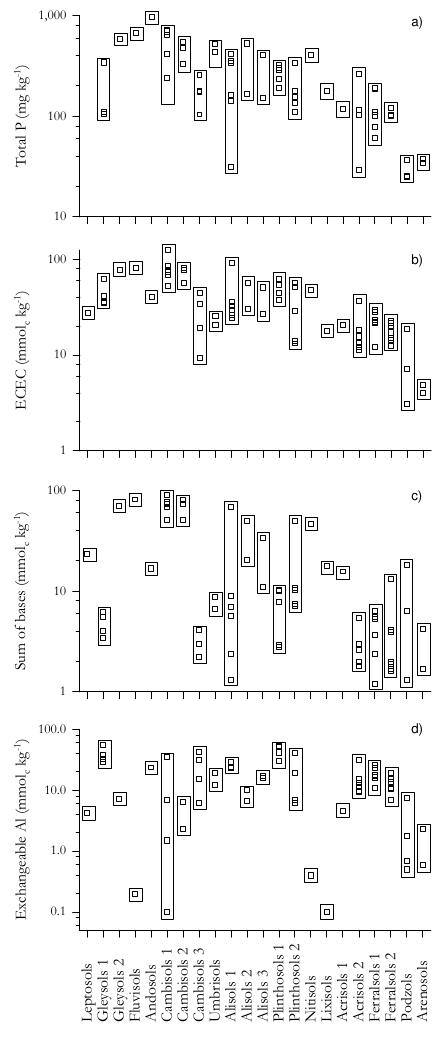
Fig. 3. (a) and (b) : Ranges of total phosphorus (top) and effective cation exchange capacity ( I E below) across the soil age gradient. (c) and (d) : Ranges of sum of bases P B (top) and exchange aluminium [Al] E (below) across the soil age